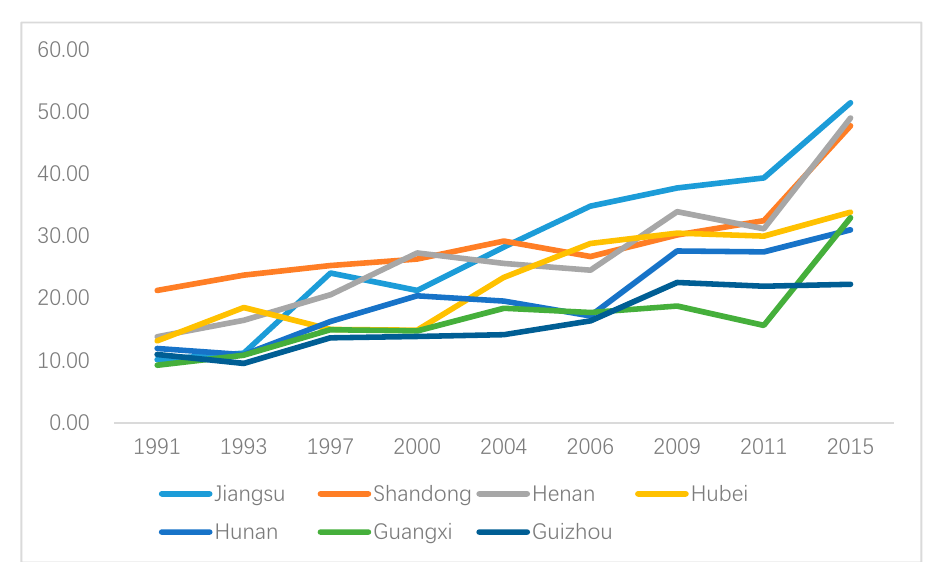
Int. J. Environ. Res. Public Health 2019 , 16 , x Figure 2. Hypertension prevalence during 1991 to 2015. Figure 2. Hypertension prevalence during 1991 to 2015.